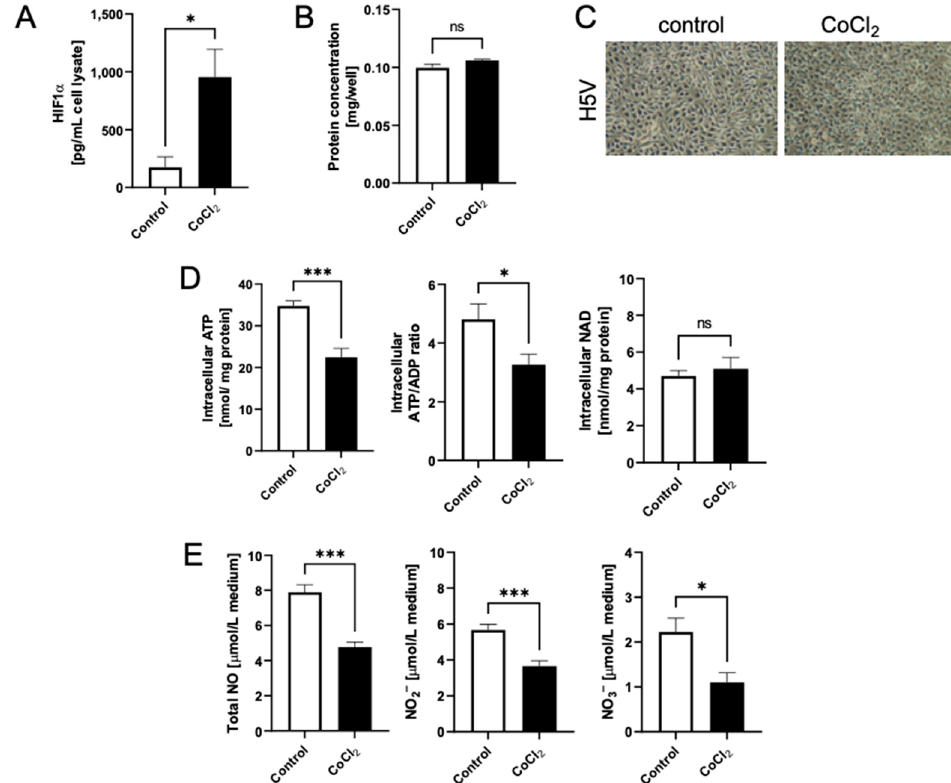
Figure 1. CoCl 2 -mimicked hypoxia depleted intracellular ATP concentration and endothelial cell function in murine heart endothelial cells (H5Vs). ( A ). HIF-1 α levels were determined in H5V cell lysate in control cells and following 24 h stimulation with 100 μ M CoCl 2 ; ( B ). Total cell protein, ( C ). Representative H5V cell images, ( D ). Intracellular ATP and NAD concentration, ( E ). The concentration of total NO, NO 2– and NO 3– in the cell culture media of control cells and after 24 h of hypoxia-mimic conditions. Results are shown as mean ± SEM; n = 6; * p < 0.05; *** p < 0.001; ns = not significant.